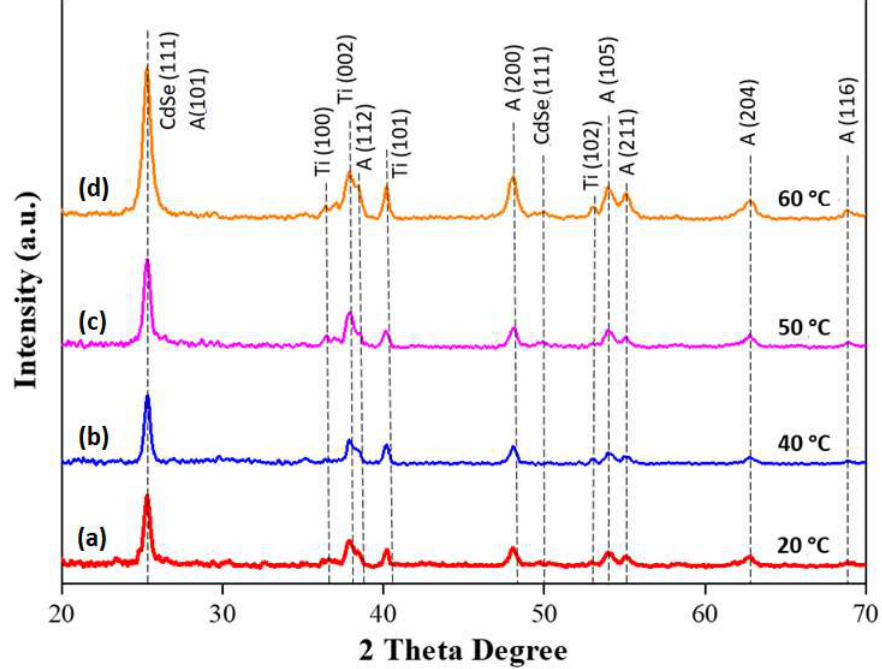
Figure 3. XRD diffraction patterns of CdSe–TiO 2 nanotube thin films soaked at ( a ) 20 °C, ( b ) 40 °C, ( c ) Figure 3. XRD di ff raction patterns of CdSe–TiO 2 nanotube thin films soaked at ( a ) 20 ◦ C, ( b ) 40 ◦ C, 50 °C, and ( d ) 60 °C in 5 mM CdSe bath solution for 1 h (A = anatase TiO 2 , T = Ti metal). ( c ) 50 ◦ C, and ( d ) 60 ◦ C in 5 mM CdSe bath solution for 1 h (A = anatase TiO 2 , T = Ti